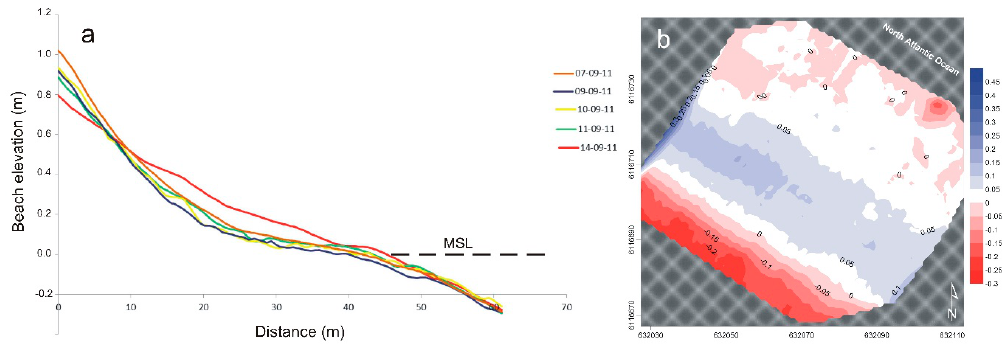
Table 2. Volumetric variation (m 3 ) between surveys and at the end of the monitoring program.